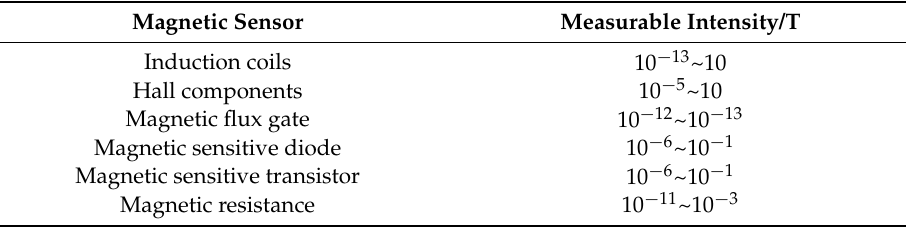
Table 1. Measurement ranges of magnetic